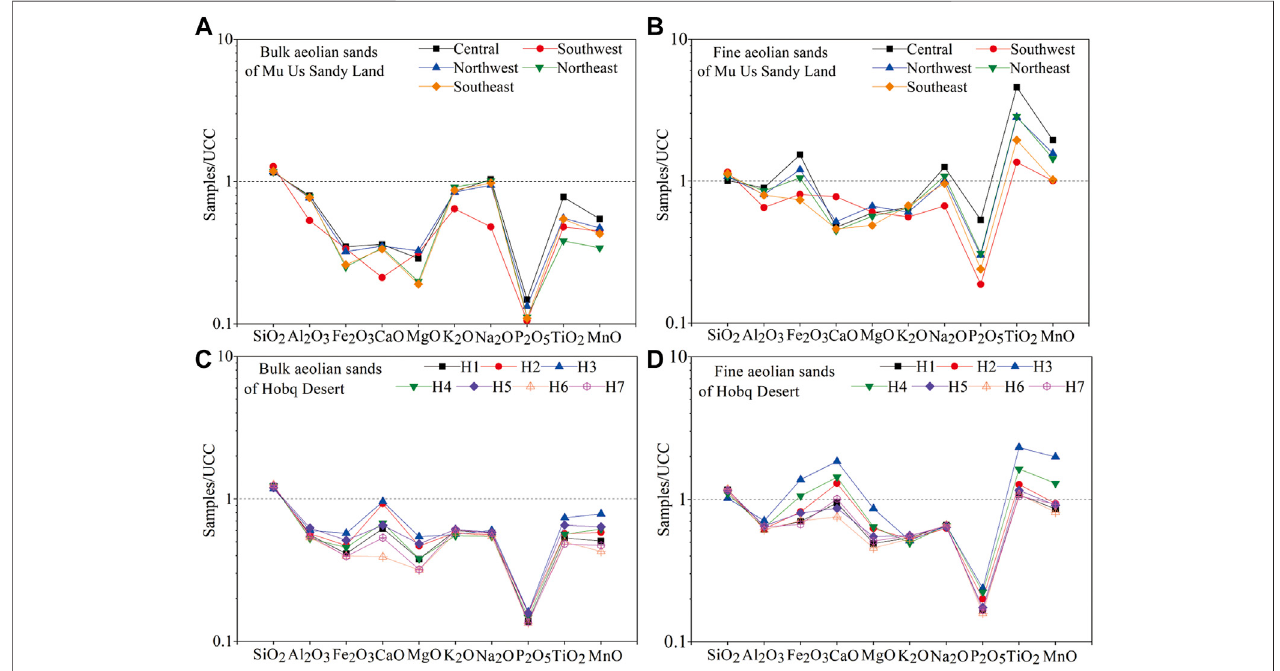
FIGURE 4 | UCC-normalized diagrams of major elements. (A,B) are for bulk and fi ne fraction sands in the Mu Us Sandy Land, respectively. (C,D) are for bulk and fi ne fraction sands in the Hobq Desert, respectively. UCC values from Taylor and McLennan (1985).